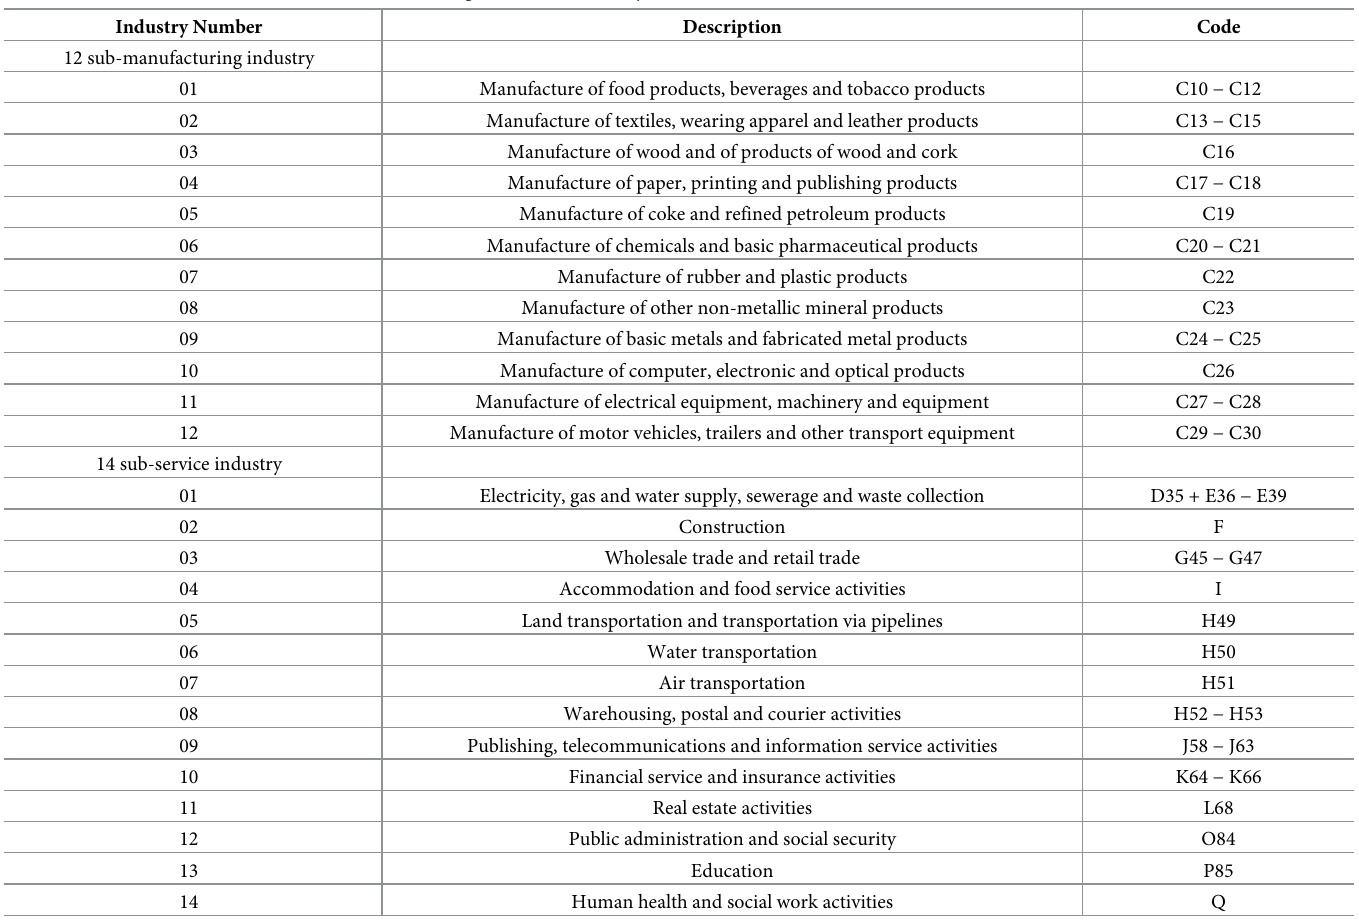
Table 13. The classification of subdivided manufacturing and service industry. Industry